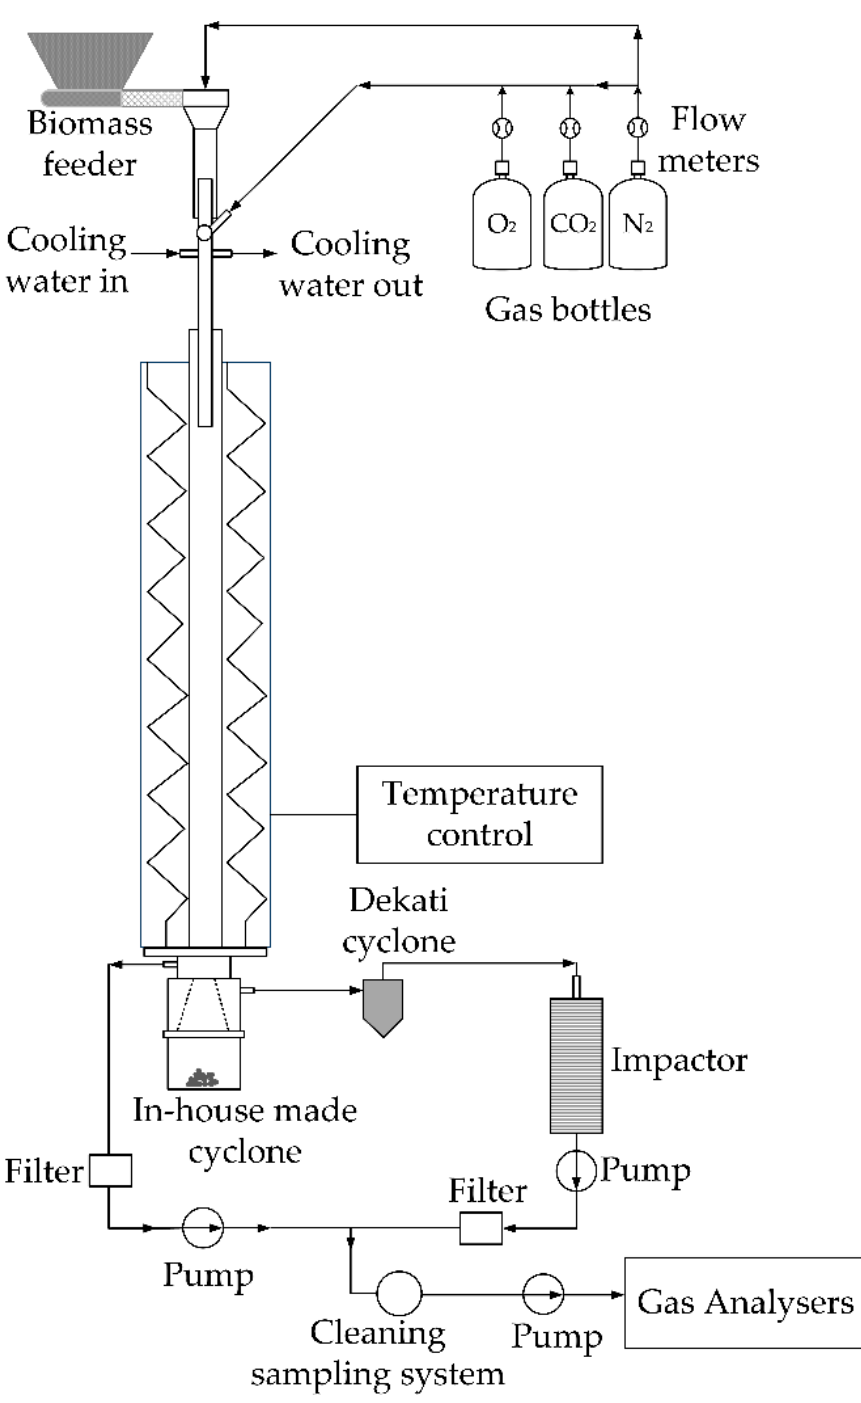
Figure 1. Scheme of the experimental installation.